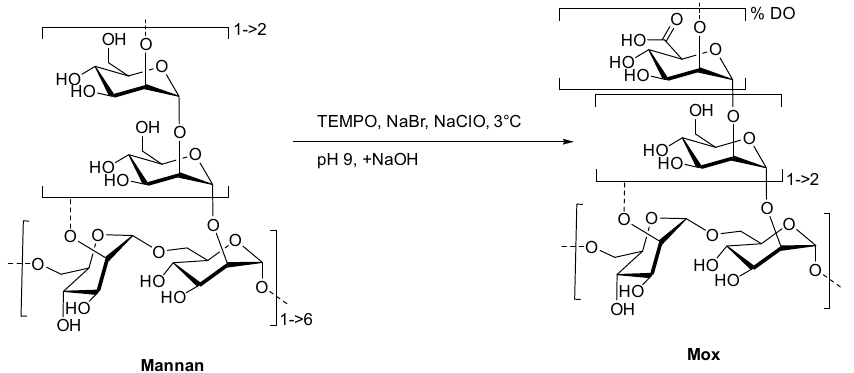
Figure 3. Formation of Mox following TEMPO-catalyzed oxidation.